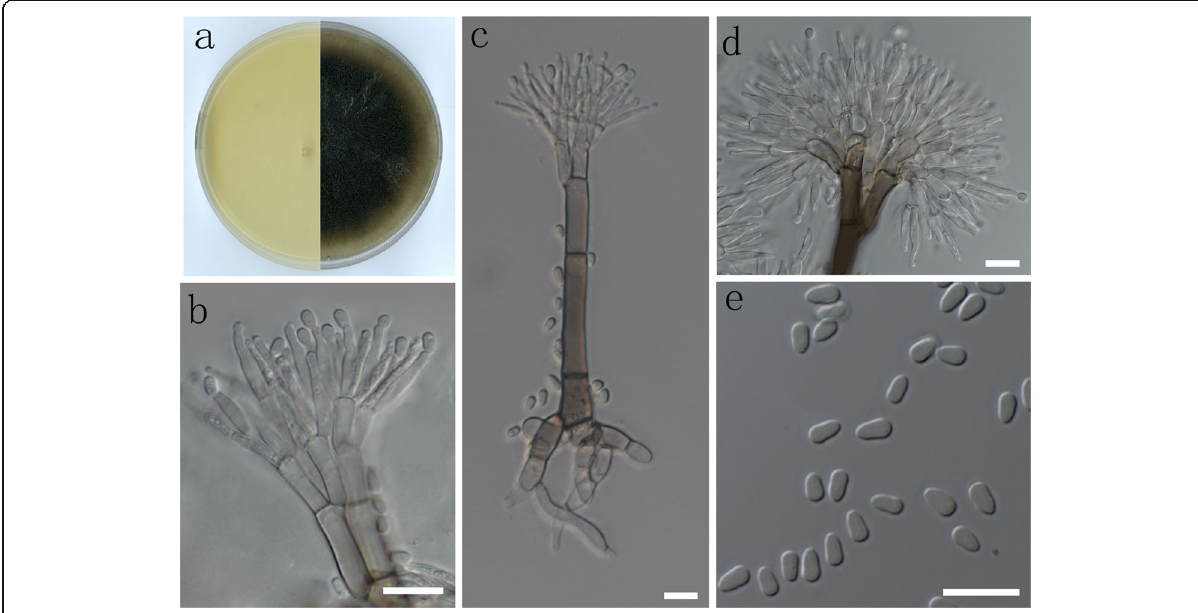
Fig. 8 Morphological characters of asexual structure of Grosmannia zekuensis sp. nov. a Cultures on malt extract agar (MEA); b , d conidiogenous apparatus; c conidiophore; e conidia. Scale bars: 10 μ